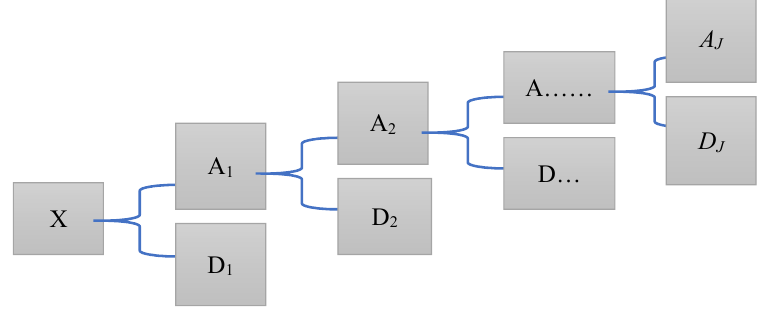
Figure 5. Wavelet decomposition of wind speed.